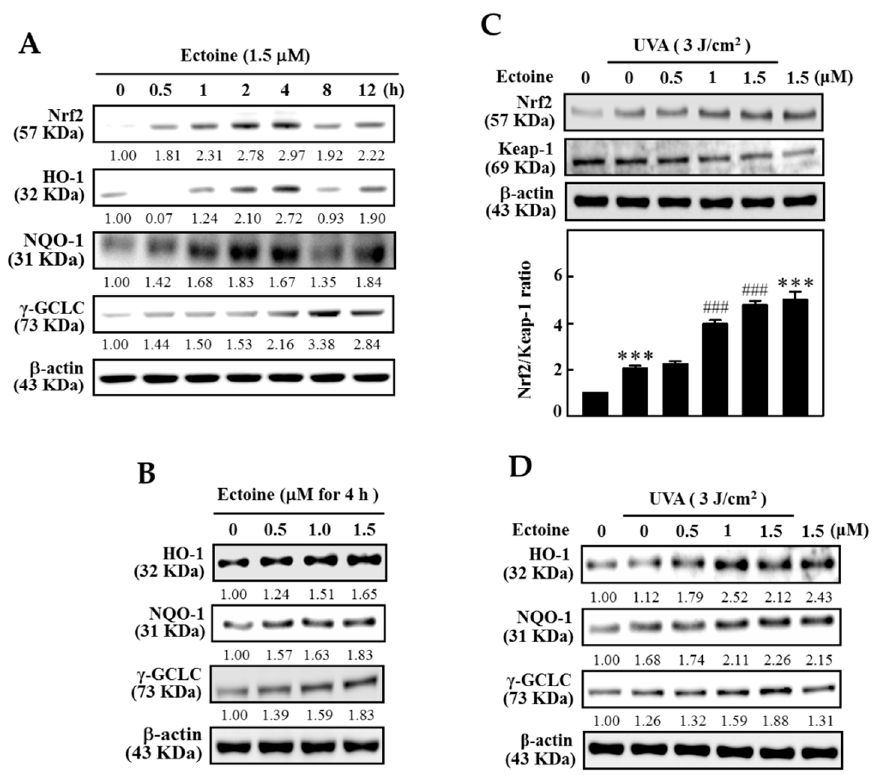
Figure 5. Ectoine mediated differential expressions of antioxidant genes in UVA irradiated HaCaT cells. ( A , B ) Western blot method was used to determine the effects of time (0–12 h) and Ectoine concentrations (0–1.5 μ M) on the expressions of Nrf2 and antioxidant genes (HO-1, NQO-1, and γ -GCLC) in HaCaT cells. ( C , D ) Effect of Ectoine pretreatment effect on the Nrf2/Keap-1 ratio of HaCaT cells irradiated with UVA. Cells were pre-treated with Ectoine (0–1.5 μ M for 24 h), and then irradiated in the absence or presence of 3 J/cm 2 UVA. The ratio of Nrf2/Keap-1 ( C ) and antioxidant gene (HO-1, NQO-1, and γ -GCLC) expressions ( D ) were determined by Western blotting. Statistical significance was assigned as *** p < 0.001 compared to the untreated cells and ### p < 0.001 compared to the UVA exposed HaCaT cells.